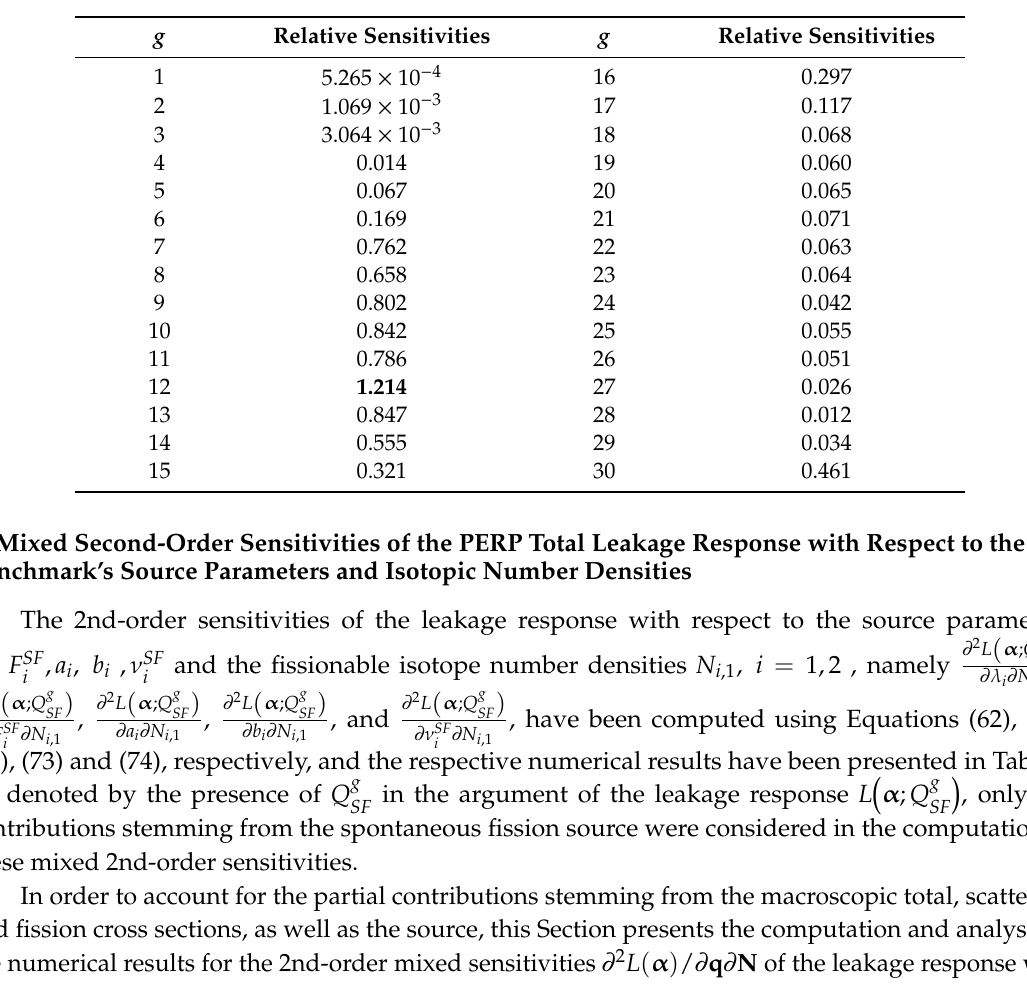
Table 14. Second-Order Relative Sensitivities S ( 2 ) (cid:16) N 2,1 , ν g S ( 2 )